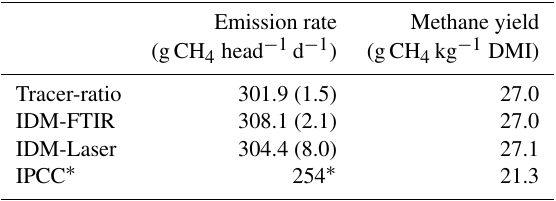
Table 1. Methane emission rates from the three micrometeoro- logical measurements (tracer-ratio, IDM-FTIR, IDM-Laser) and an emission estimate based on the dry matter intake of the ani- mals (using an IPCC recommended calculation ∗ ). Methane yield (gCH 4 kg − 1 DMI) is also